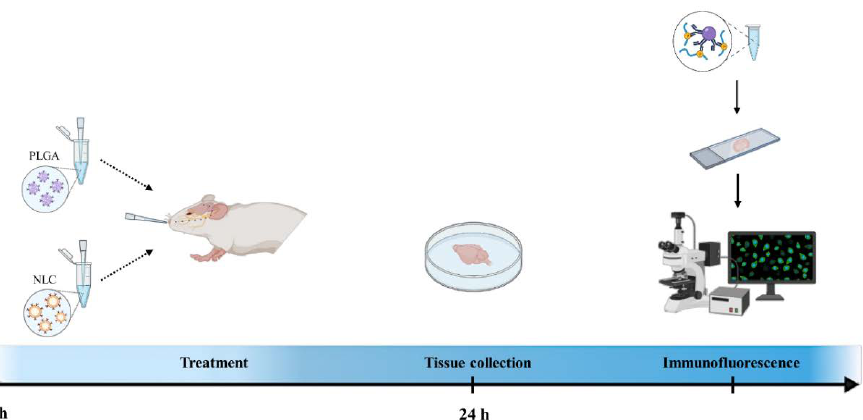
Figure 4. Experimental design for the nanoparticles administration. Twelve-month-old wild-type (WT) and 3xTg-AD mice were intranasally administered with both empty and anti-TRAIL loaded nanoparticles (PLGA or NANO-A and NLC or NANO-B NPs). After 24 h, brains were collected for immunofluorescence analysis. Created with www.BioRender.com (accessed on 10 February 2022) . Immunofluorescence images revealed the presence of low levels of the naïve anti- body in the brain of both WT and 3xTg-AD mice, whereas the hippocampus of mice treated with NANO-A or NANO-B complex showed a significantly increased level of both complexes (Figure 5). Figure 5. Comparison of polymeric or lipidic nanoparticles complexed with anti-TRAIL in the hip- pocampus of 3xTg-AD mice after intranasal administration. Representative immunofluorescence